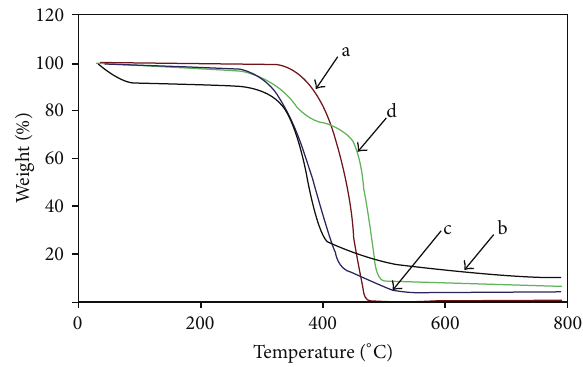
Figure 9: Thermograms of (a) PP, (b) RHF, (c) PP/RHF, and (d)